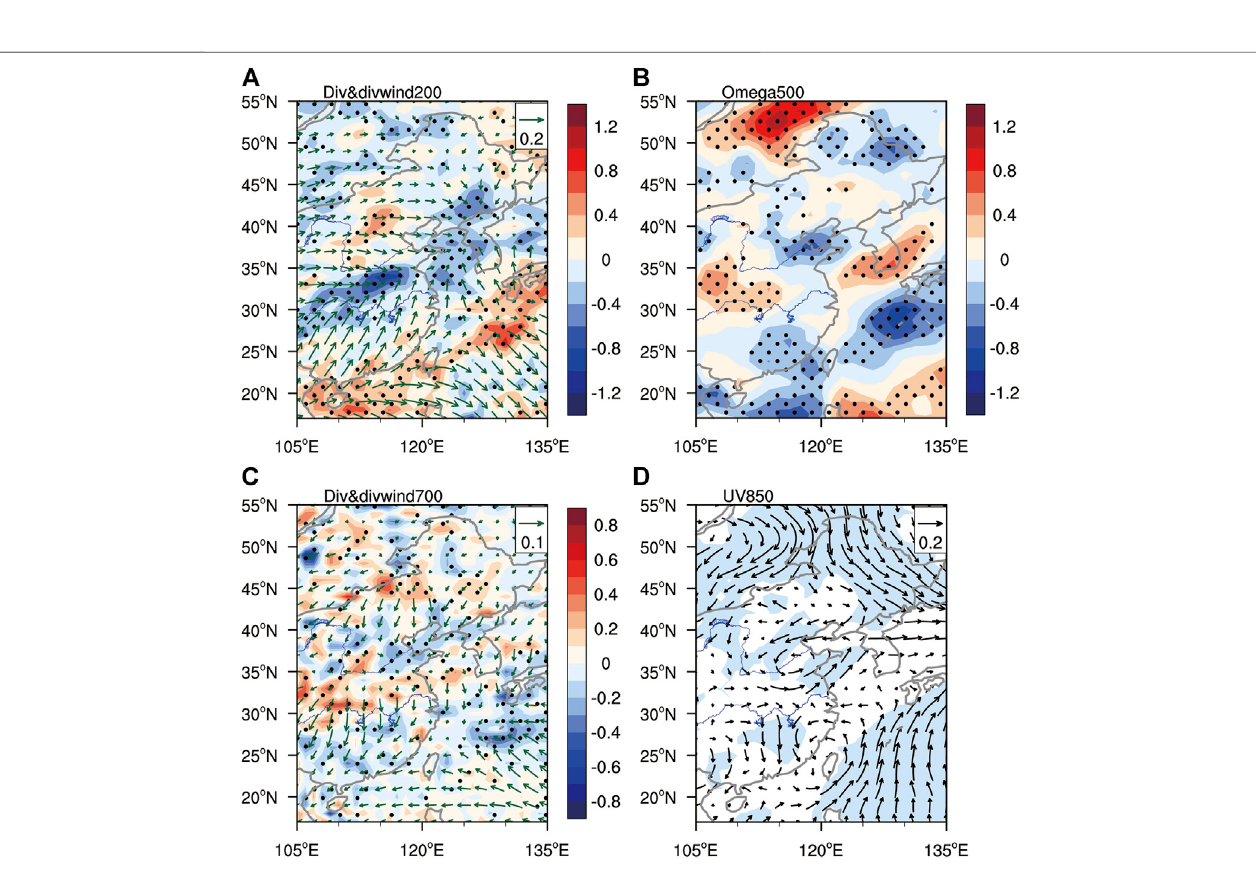
Frontiers in Earth Science |